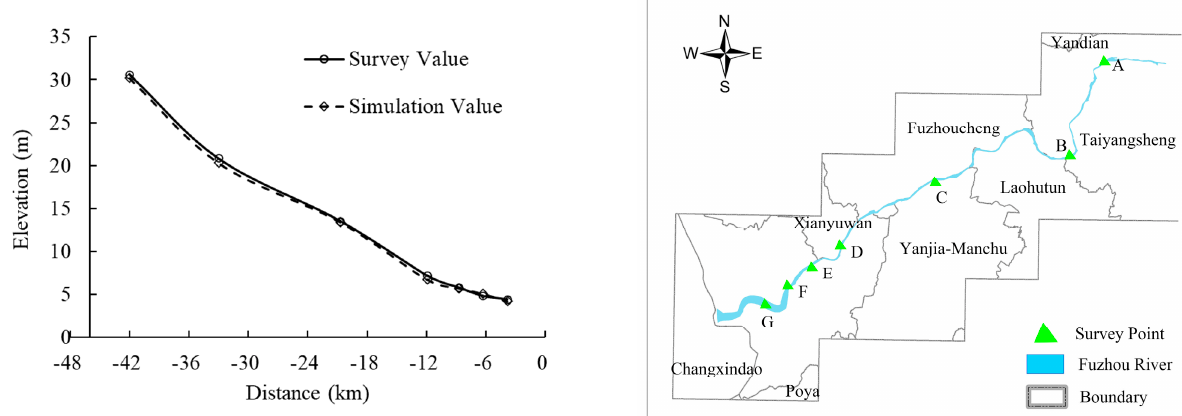
Figure 4. Simulated and observed values of river flood water level in 2012.